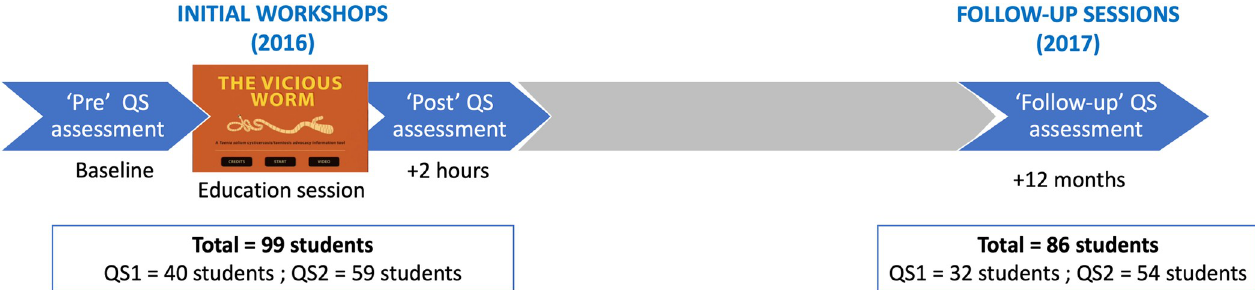
Fig 2. Timeline of ‘The Vicious Worm’ educational sessions in the three study arms. Initial workshops in 2016 consisted of a ’pre’ questionnaire (QS), an educational session using ‘The Vicious Worm’, and a ’post’ QS immediately after. The ’follow-up’ QS sessions were conducted one year later. QS1 was used in the elimination study arm; QS2 was used in the control and negative control study